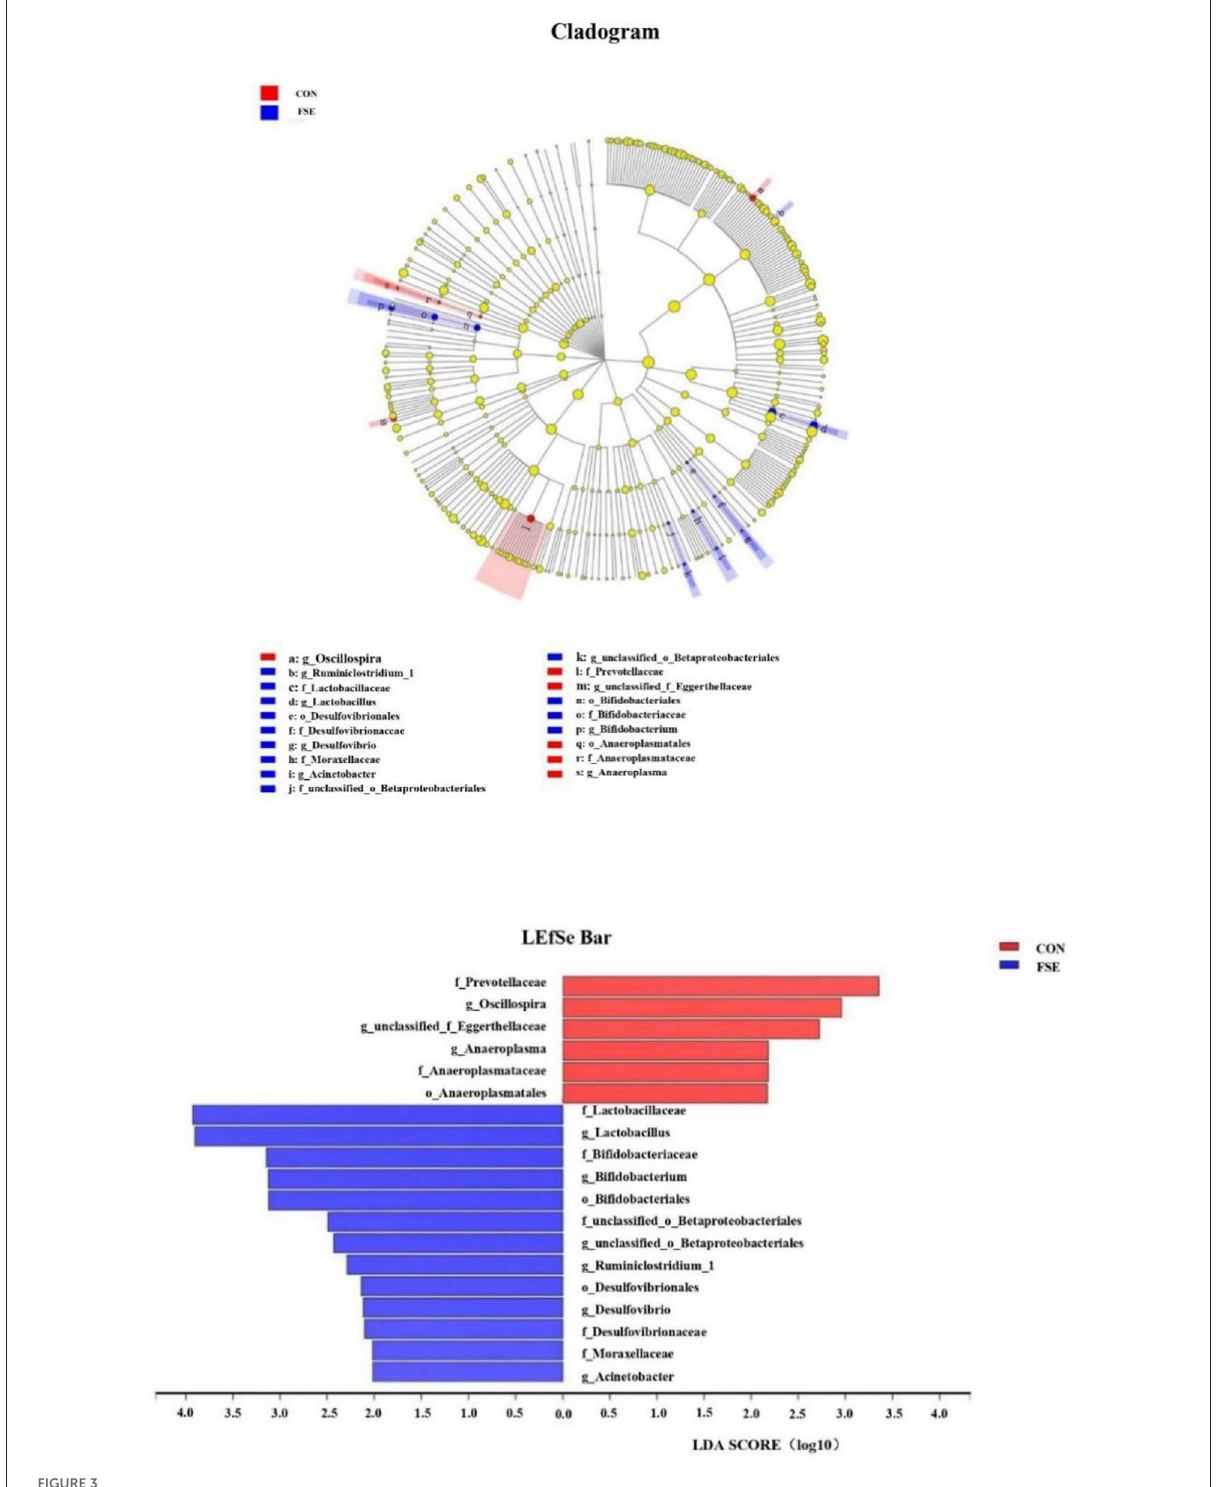
FIGURE3 Key phylotypes of microbiota communities in colon digesta of finishing pigs fed basal diets (CON) or basal diet with Forsythia suspensa extract (FSE) were identified using linear discriminant analysis effect size (LEfSe) analyses. Taxonomic differences between FSE and CON are represented by the color of the most abundant class (red for CON, blue for FSE). The diameter of each circle represents the relative abundance of the taxon. The central point represents the root of the tree (Bacteria), and each ring represents the next lower taxonomic level (phylum to genus: p, phylum; c, class; o, order; f, family; g, genus). LEfSe analysis used the Kruskal-Wallis rank sum test to detect significantly different abundances and performs LDA scores to estimate the effect size (Threshold: ≥ 2). n =